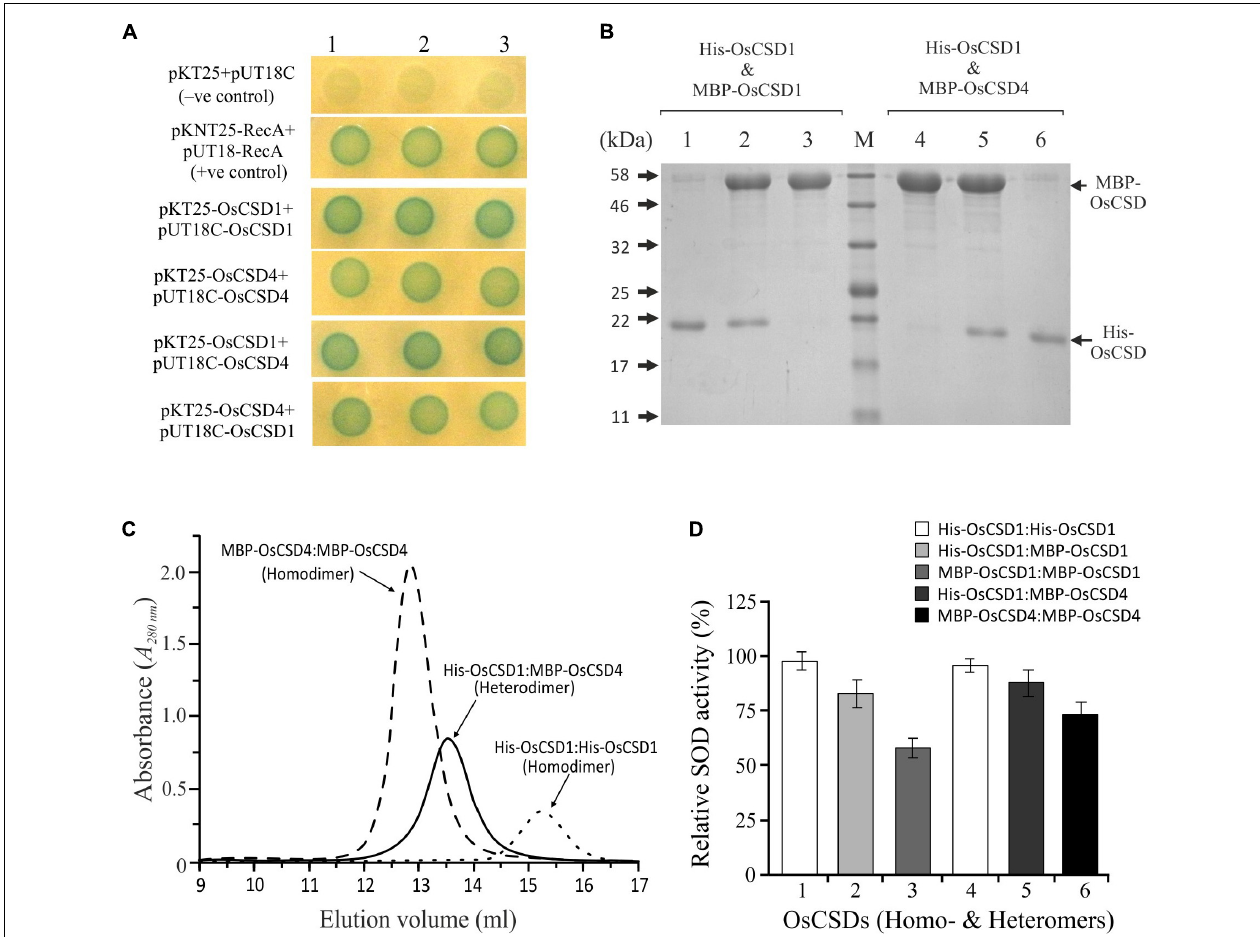
FIGURE 8 | Analysis of heteromeric interaction between rice OsCSD1 and OsCSD4 subunits by BACTH system. (A) E. coli (BTH101) cells co-transformed with different combinations of pKT25 and pUT18C plasmids expressing OsCSD1 and OsCSD4 fusion proteins were analyzed by spot test assay. Cells containing empty plasmids served as negative control, while the positive control contained plasmids pKNT25-RecA + pUT18-RecA. (B) SDS-PAGE analysis of heterodimer and homodimer forms separated after Ni-NTA/amylose affinity purification of co-expressed OsCSDs, lane 1, His-OsCSD1:His-OsCSD1 (homodimer); lane 2, His-OsCSD1:MBP-OsCSD1 (heterodimer); lane 3, MBP-OsCSD1:MBP-OsCSD1 (homodimer); lane 4, MBP-OsCSD4:MBP-OsCSD4 (homodimer); lane 5, His-OsCSD1:MBP-OsCSD4 (heterodimer); lane 6, His-OsCSD1:His-OsCSD1 (homodimer); lane M, protein molecular weight standards. (C) Gel-filtration profiles of two different homodimers (MBP-OsCSD4:MBP-OsCSD4 and His-OsCSD1:His-OsCSD1) and heterodimer (His-OsCSD1:MBP-OsCSD4) forms. (D) Analysis of SOD activity of OsCSD homodimer and heterodimer forms by NBT reduction